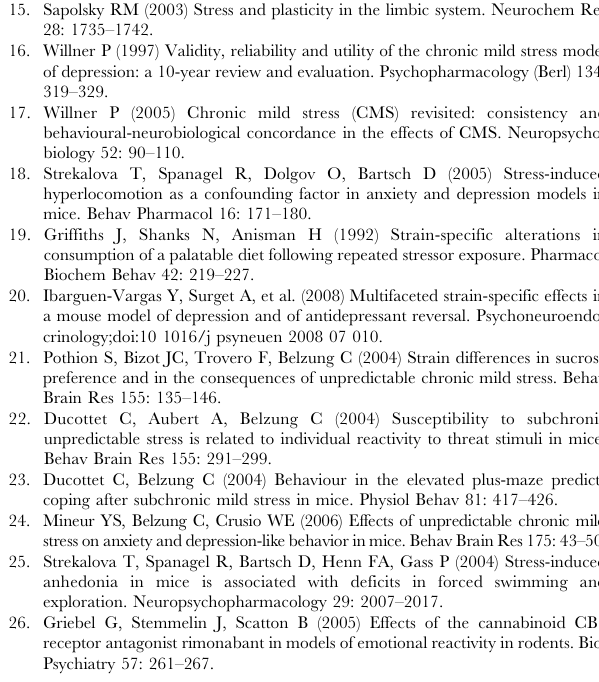
Figure S1 Effects of short-term CMS on saccharin consumption per 2 hrs in other mouse strains Effects of CMS on saccharin intake over a period of 3-4 weeks in Balb/c, D2JIco, FVB and NMRI mice (measurement 2x/week). White circles: control group, black circles: CMS group. First 4 data points of each graph represent basal consumption. Data represent mean 6 SEM, n= 8- 24/group. * p , 0.05, ** p , 0.01 pairwise between-group compar- isons (Student’s t-test). Table S1 Inter-strain comparison of saccharin intake before and after CMS application in stressed animals. Averaged saccharin intake during 2 weeks under basal conditions, the same parameter corrected for body weight and averaged intake during the first 3- 4 weeks of CMS (as percentage of basal intake). a-f indicate significant differences to Balb/c, BL/6J, D2JIco, D2Ola, FVB and NMRI mice, respectively (Tukey test). Data represent mean 6- SEM of CMS animals only, n=